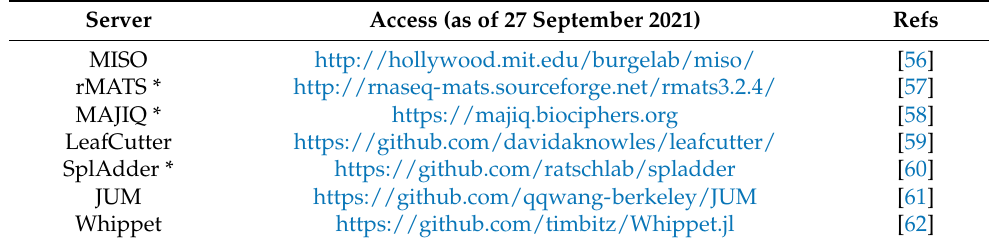
Table 3. Software for identifying alternative splicing events as part of neoantigen